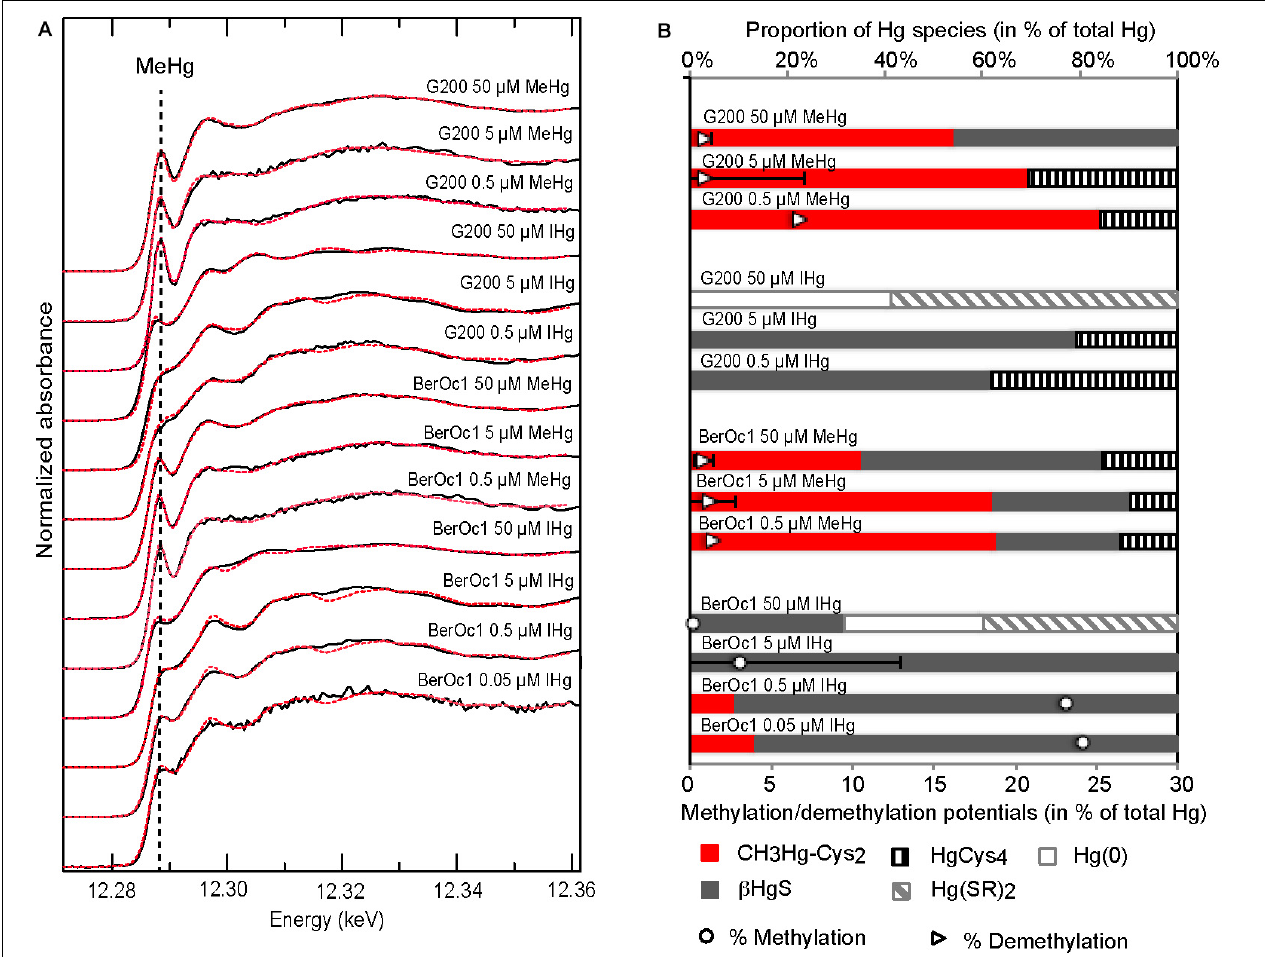
FIGURE 3 | Mercury speciation in BerOc1 and G200 by Hg L 3 -edge HERFD-XANES spectroscopy. (A) Spectra of BerOc1 and G200 exposed to various concentrations of MeHg and IHg (black lines) and their linear combination fit (dashed red lines). (B) Proportion of Hg species determined from linear combination fitting of the spectra from BerOc1 and G200 displayed in (A) plotted with the methylation and demethylation potentials.